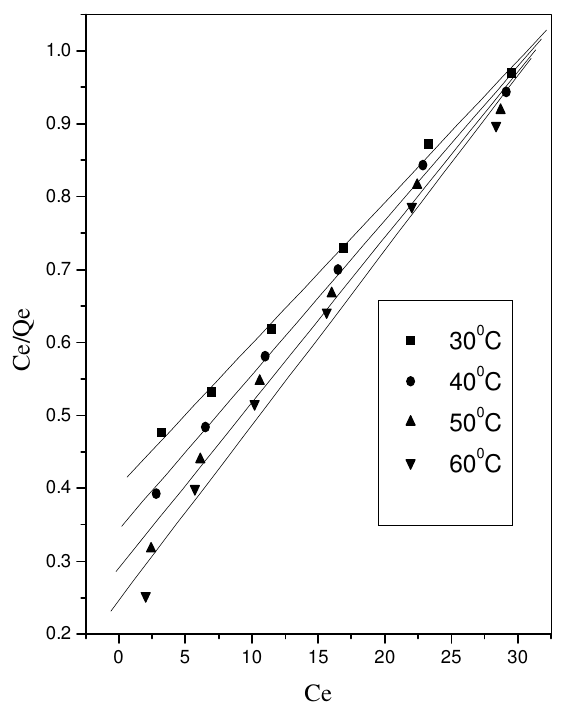
Figure 3 . Langmuir adsorption isotherm for the adsorption of RDB by PSC Table 3 . Langmuir isotherm results